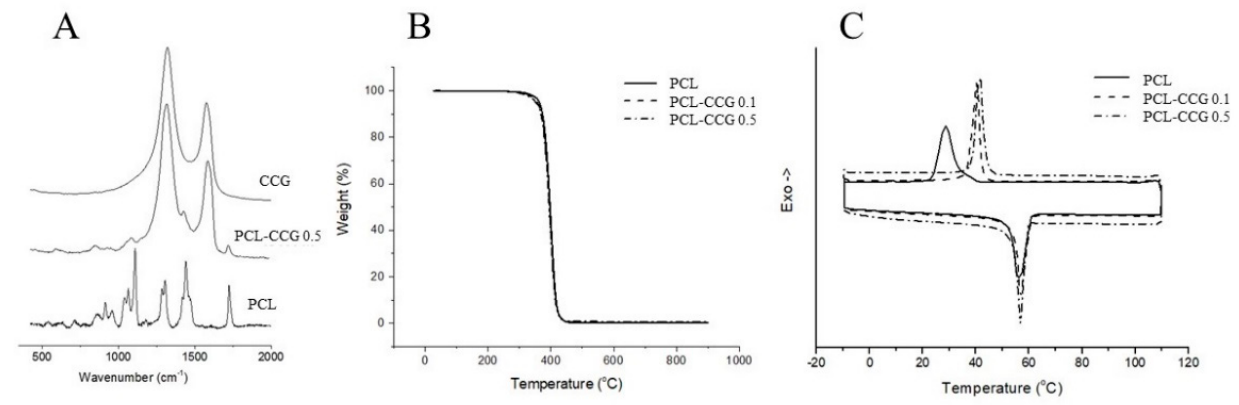
Figure 4. Raman spectra ( A ), TGA ( B ) and DSC ( C ) curves of PCL and PCL-CCG composites.